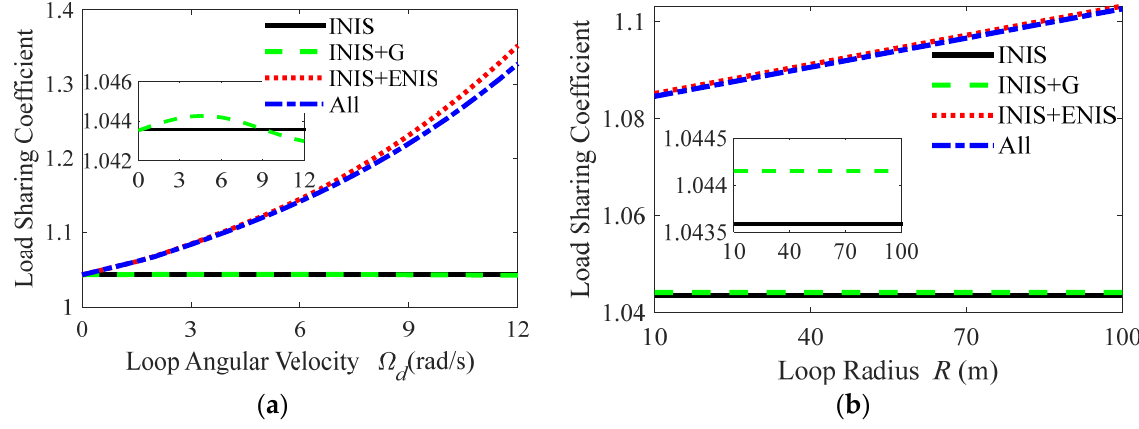
Figure 18. The influence of different terms on LSC. ( a ) At different LAV; ( b ) At different LR.